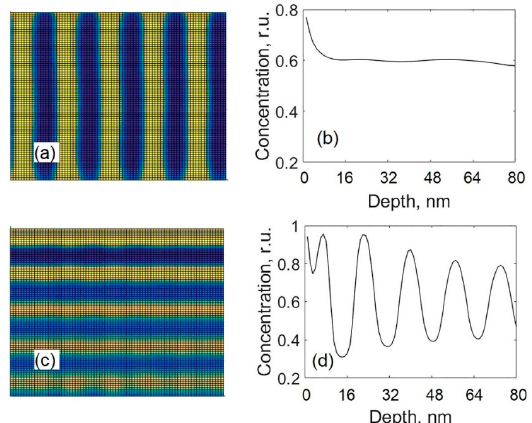
Figure 9. Cross-sectional views and depth profiles of carbon obtained with different values of W a – W b : W a – W b = 4.8 × 10 8 J/m 3 ( a , b ); W a – W b = 9.6 × 10 8 J/m 3 ( c , d ).